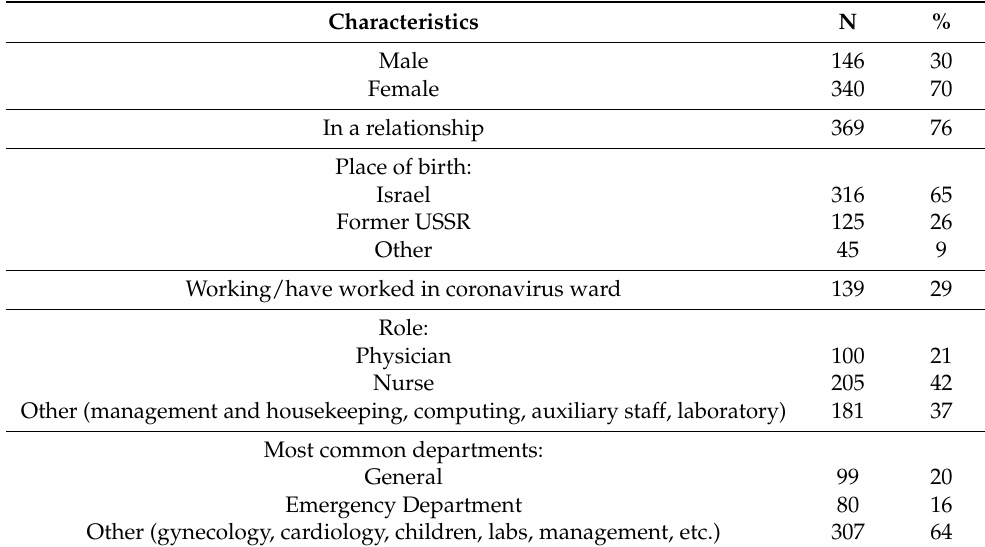
Table 1. Study sample characteristics ( n =